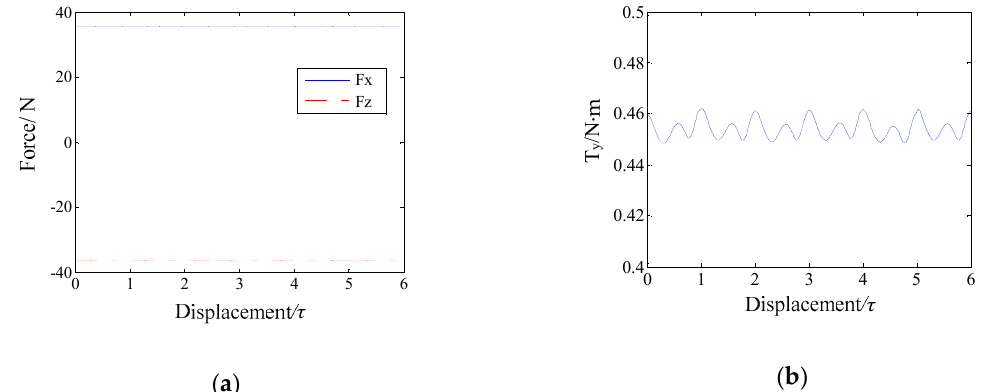
Figure 11. Electromagnetic force and torque: ( a ) electromagnetic thrust force F x and levitation force F z ; ( b ) torque T y .